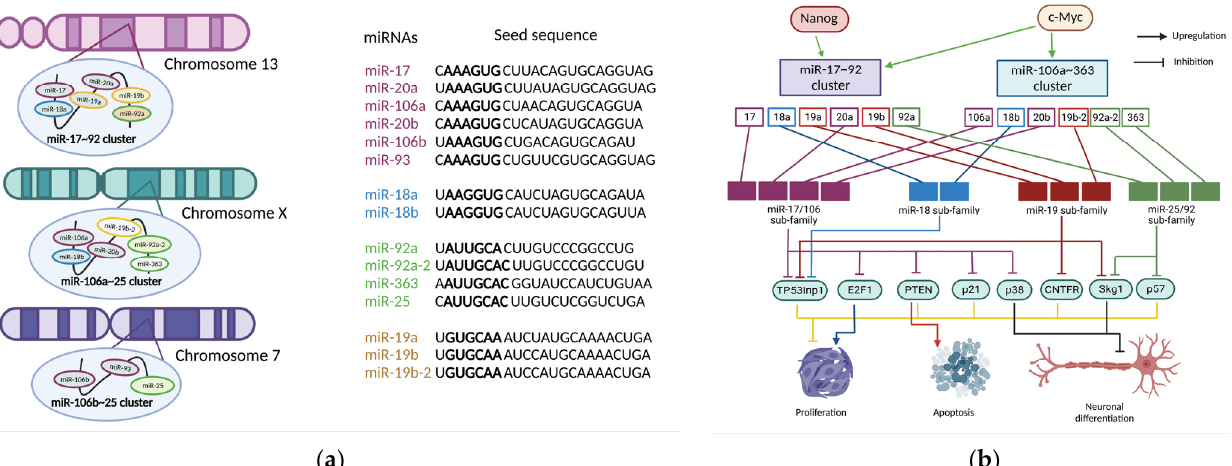
Figure 1. The miR-17~92 family, its gene structure, members, and their role in the normal development of the nervous system. ( a ) Sequences of cluster members miR-17/92 and its two paralogs miR-106a/363 and miR-106b/25. The “seed” in each case is bold. ( b ) Members of the miR-17~92 family inhibit the expression of their multiple targets, resulting in increased proliferation, accelerated neuronal differentiation, and inhibited apoptosis. miRNAs, together with target genes, function as a key regulator of ontogenetic and adult neurogenesis. This image was created using BioRender (accessed on 30 March 2022).